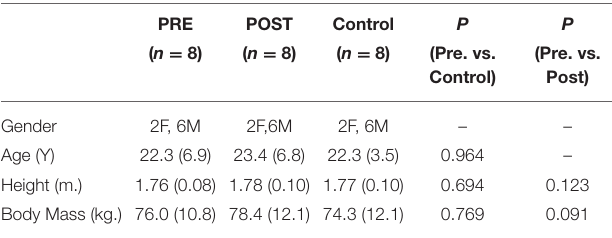
TABLE 1 | Demographics for the FAIS group at the preoperative (PRE) and postoperative (POST) time points and controls. PRE POST